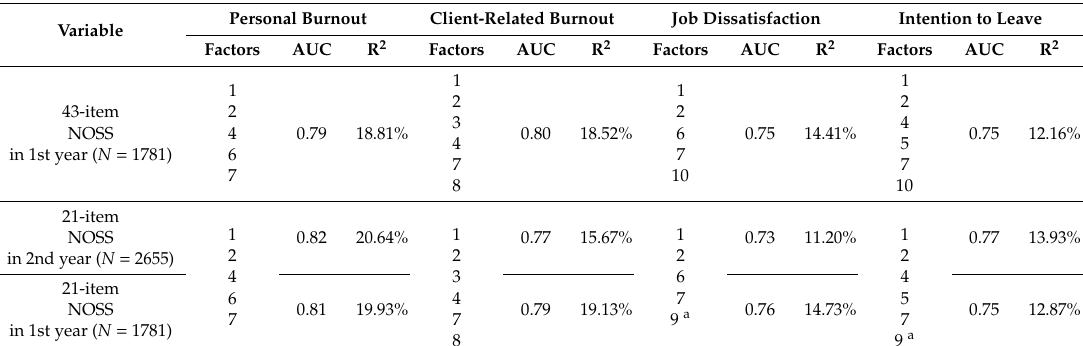
Table 5. Revision and confirmation of the